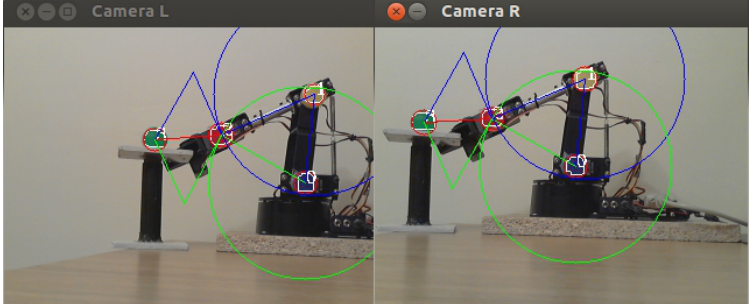
Figure 9. The image of the guide lines and circles drawn for computing the position of the robotic arm in the 3D space using two combined algorithms: distance calculation in the 2D space and stereo distance